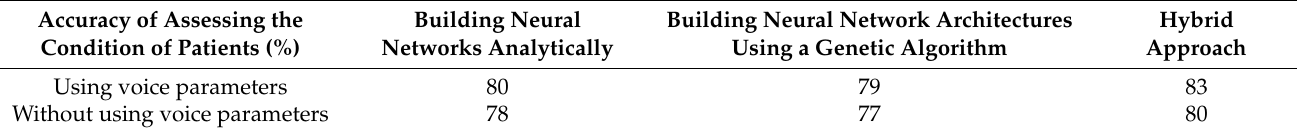
Table 6. Comparison of the accuracy of assessing the condition of patients with different approaches. Accuracy of Assessing